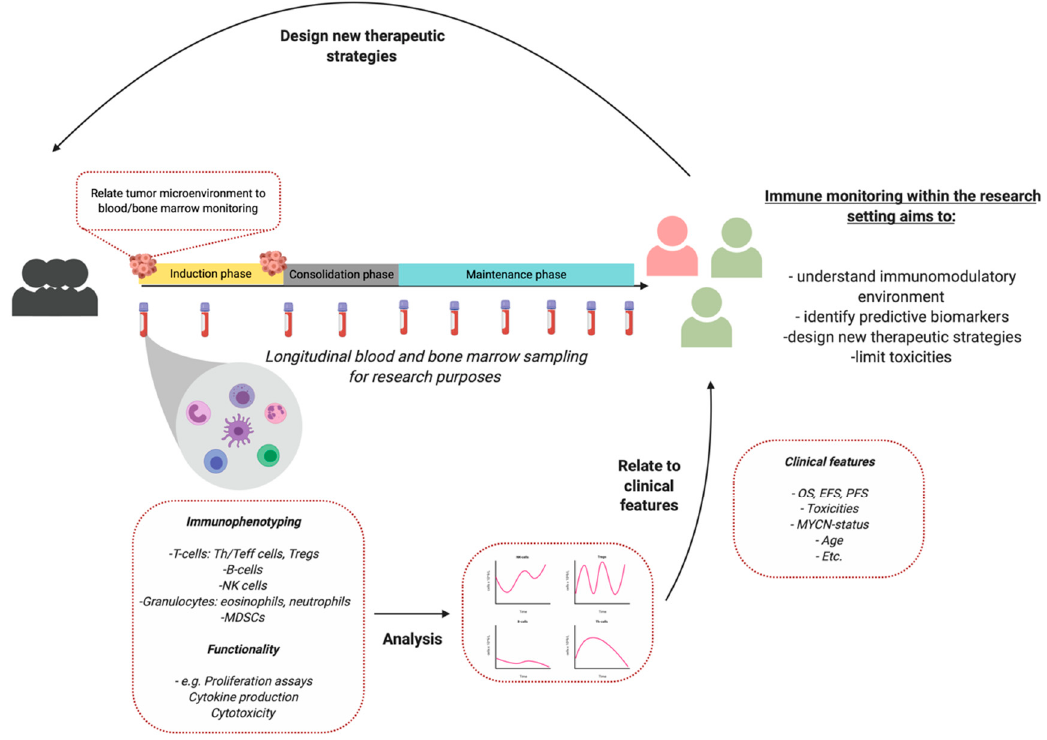
Figure 1. Immune monitoring for research purposes. Monitoring peripheral blood subsets currently have insufficient clinical value for clinical decision making. Created with BioRender.com.